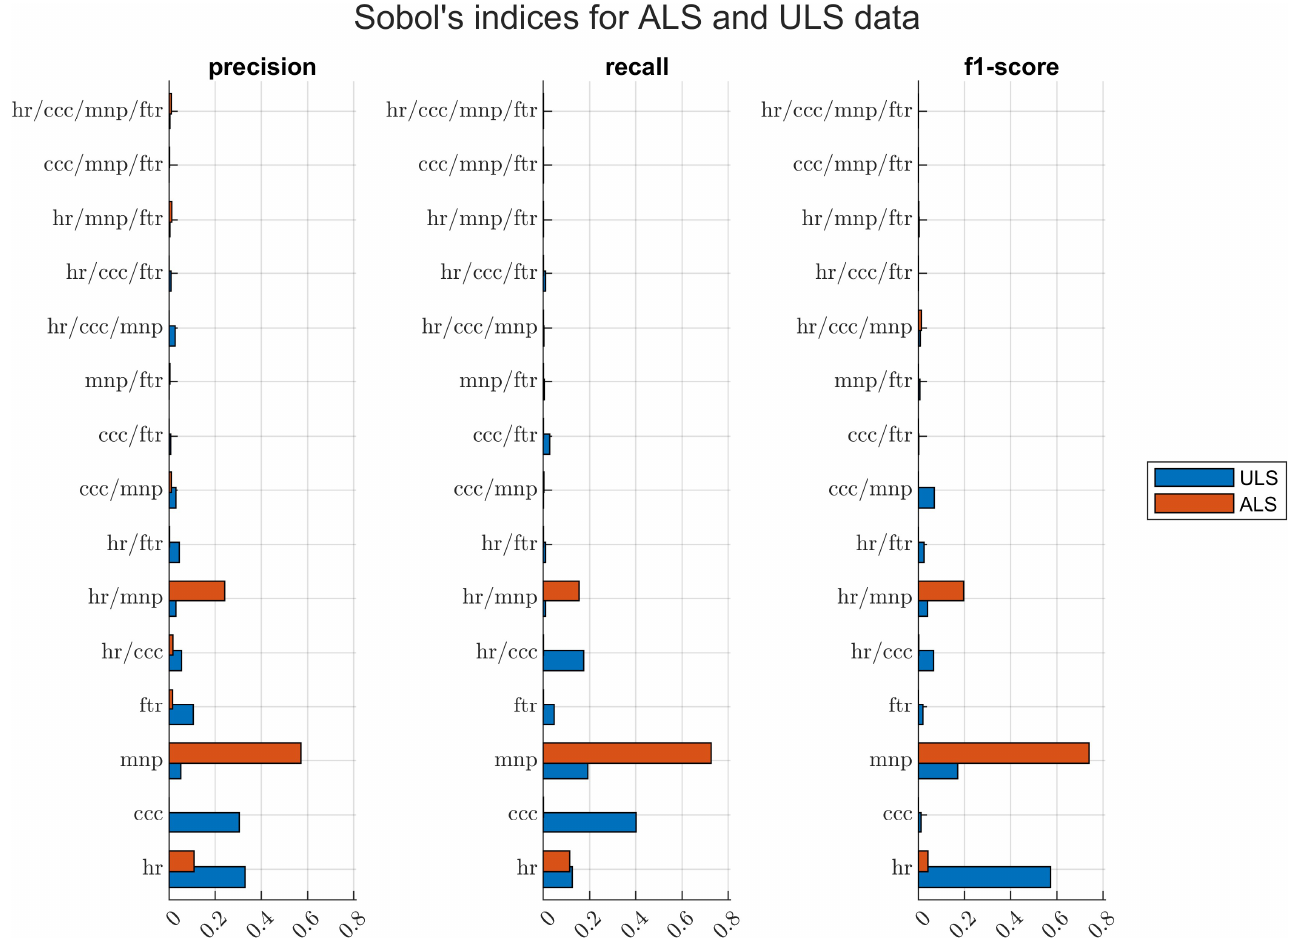
Figure 5. Sobol’s first-order indices for varied parameters and parameter combinations in ALS and ULS data. MNP denotes the minimum number of points that must fall on the same line for a line to be detected, HR denotes the height range from which fallen trees are searched, CCC denotes the connected component classifier, and FTR denotes false tree removal. For example, the row labeled ccc/mnp/ftr represents the fraction of variance in the output variable explained by the interaction between the CCC, MNP, and FTR parameters.